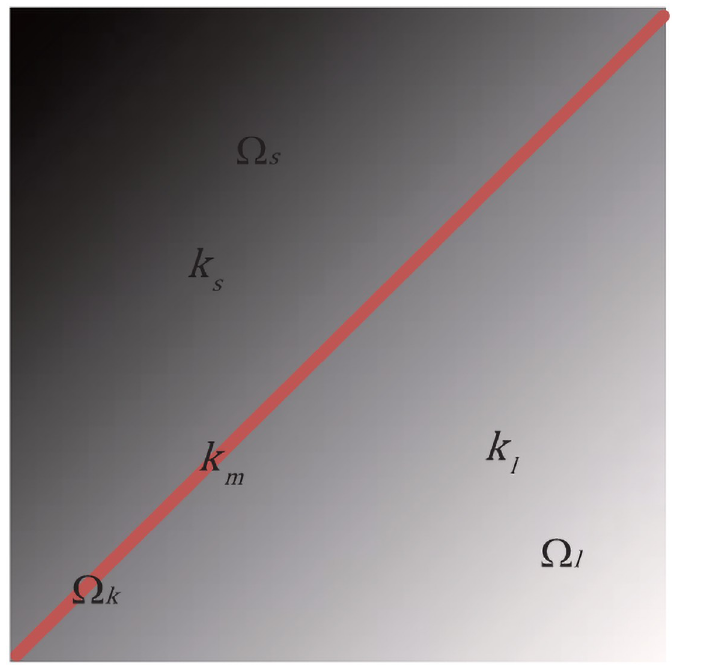
Fig 4. Illustration of regions O k , O s and O l